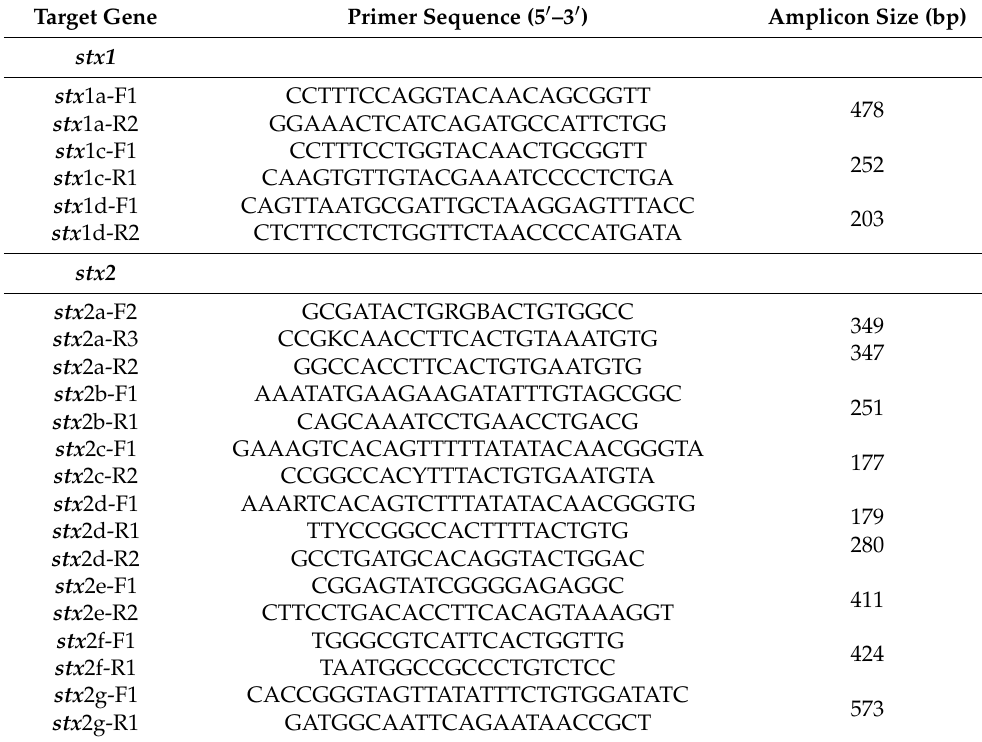
Table 2. Shiga toxin producing E. coli (STEC) target genes, their primer sequences and amplification fragment sizes for gene subtyping method developed by EU Reference Laboratory for E. coli (EURL- VTEC_Method_006_Rev 2) [48]. Target Gene Primer Sequence (5 (cid:48) –3 (cid:48) ) Amplicon Size